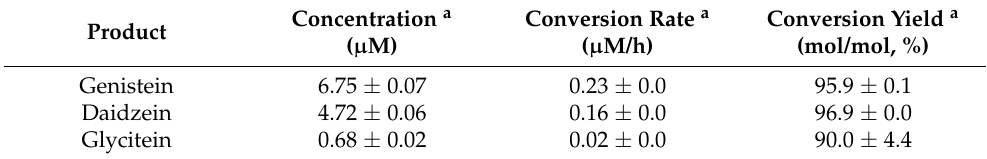
Figure 4. Bioconversion of isoflavones with standard chemicals by L. citreum wild type and L. citreum harboring pCB4270V4-IH. ( A ) Schematic diagram of bioconversion of isoflavone glycosides to aglycone forms. Red-color arrowheads indicate the hydrolysis site for IH. Bioconversion profiles of ( B ) 23.1 µ M of genistin (100 mg/L) ( C ) 24 µ M of daidzin (100 mg/L) and ( D ) 22.4 µ M of glycitin (100 mg/L). Symbols: black circle, isoflavone glycoside forms in L. citreum wild type; black square, isoflavone aglycone forms in L. citreum wild type; red circle, isoflavone glycoside forms in L. citreum harboring pCB4270V4-IH; red square, isoflavone aglycone forms in L. citreum harboring pCB4270V4-IH, white bar, conversion yields of isoflavones in L. citreum harboring pCB4270V4-IH. Results are the mean of duplicate experiments, and error bars indicate standard deviations. Table 2. Summary of isoflavone aglycone forms production with soymilk